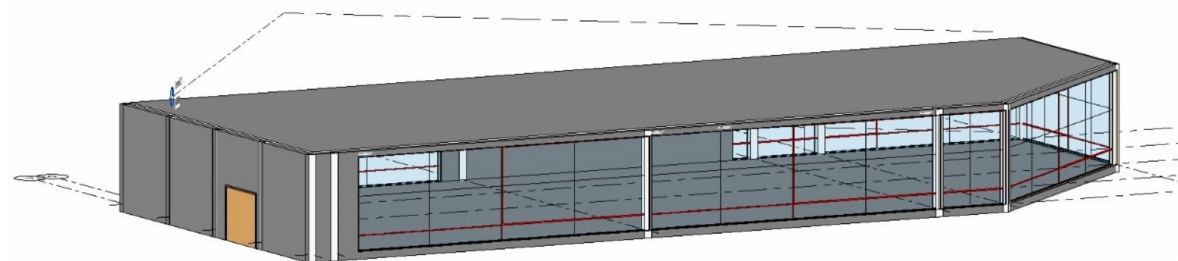
Figure 20. Case Study—ABS diamond shape BIM model.